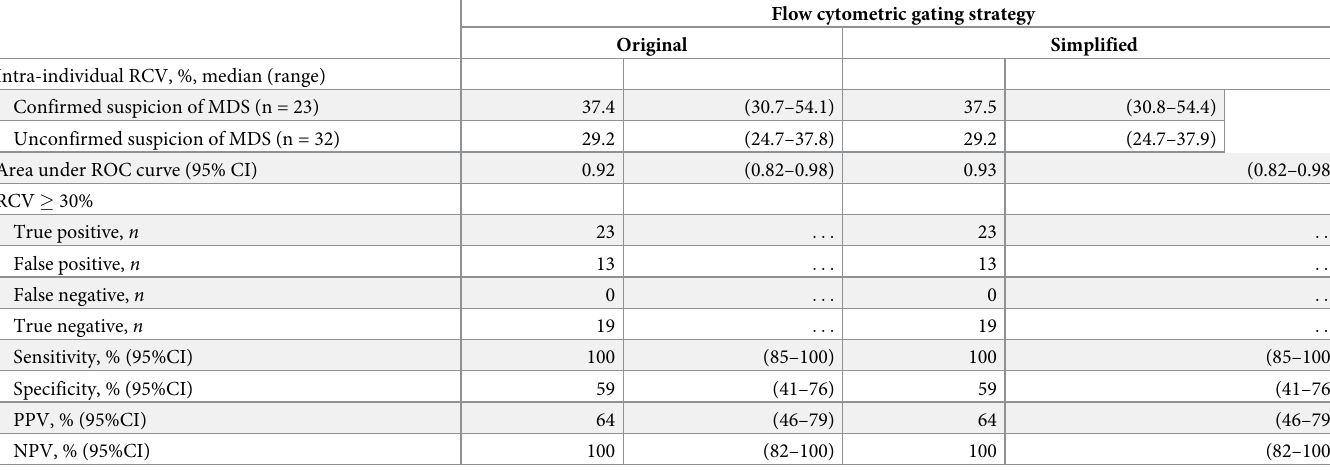
Table 3. Comparative diagnostic accuracy of intra-individual robust coefficient of variation for peripheral blood neutrophil myeloperoxidase expression between simplified and original flow cytometric gating strategies (n = 55) a